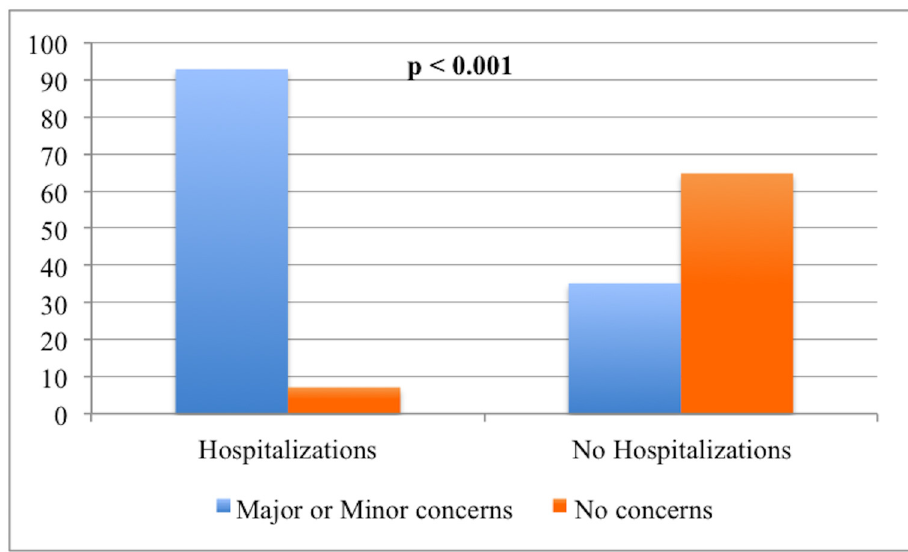
Fig 2. Relationship between unintended hospitalizations and level of